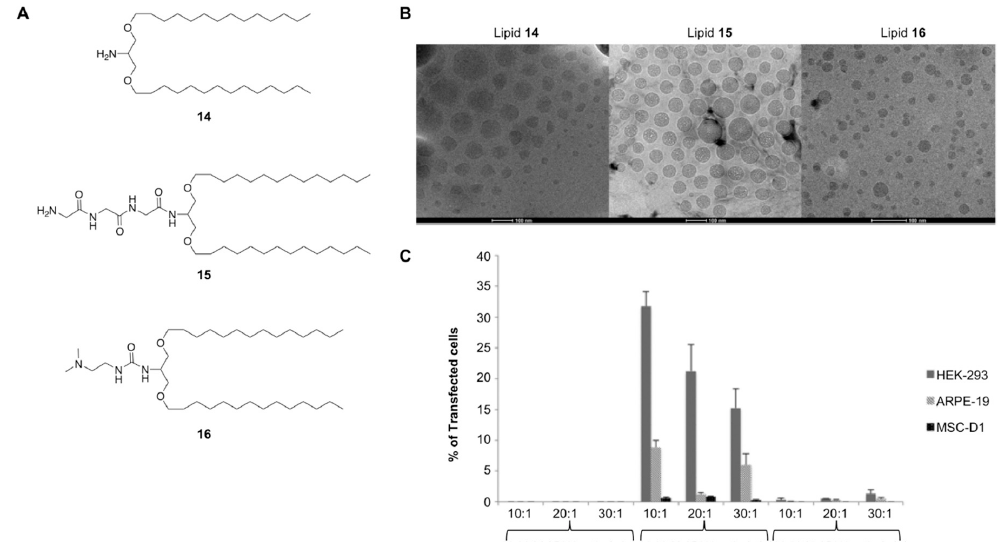
Figure 6. ( A ) Serinol-based cationic lipids that were formulated into cationic niosomes; ( B ) physical characterization by dynamic light scattering (DLS) showing spherical nanoscale patterns. Scale bar: 100 nm; ( C ) in vitro transfection efficiencies mediated using three serinol lipids. Adapted with permission from ref. [46]. Copyright 2015, The Royal Society of Chemistry.